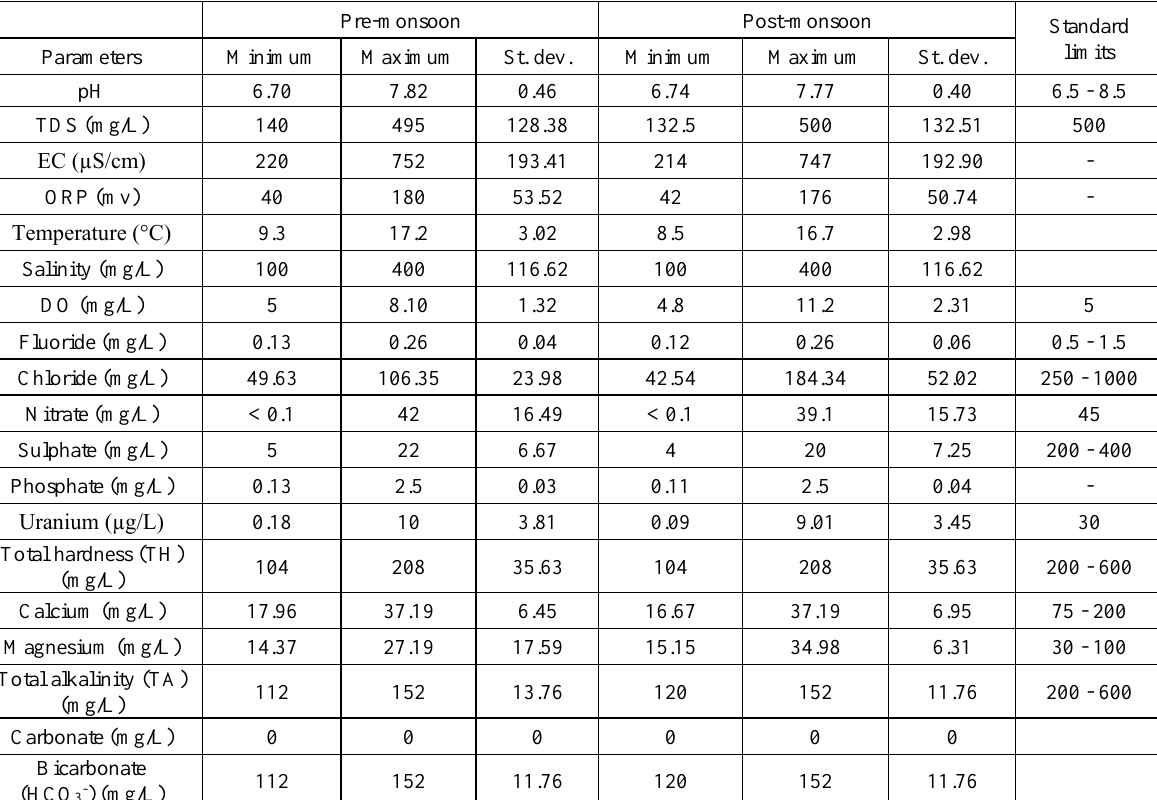
Table 2. Statistics of physicochemical parameters